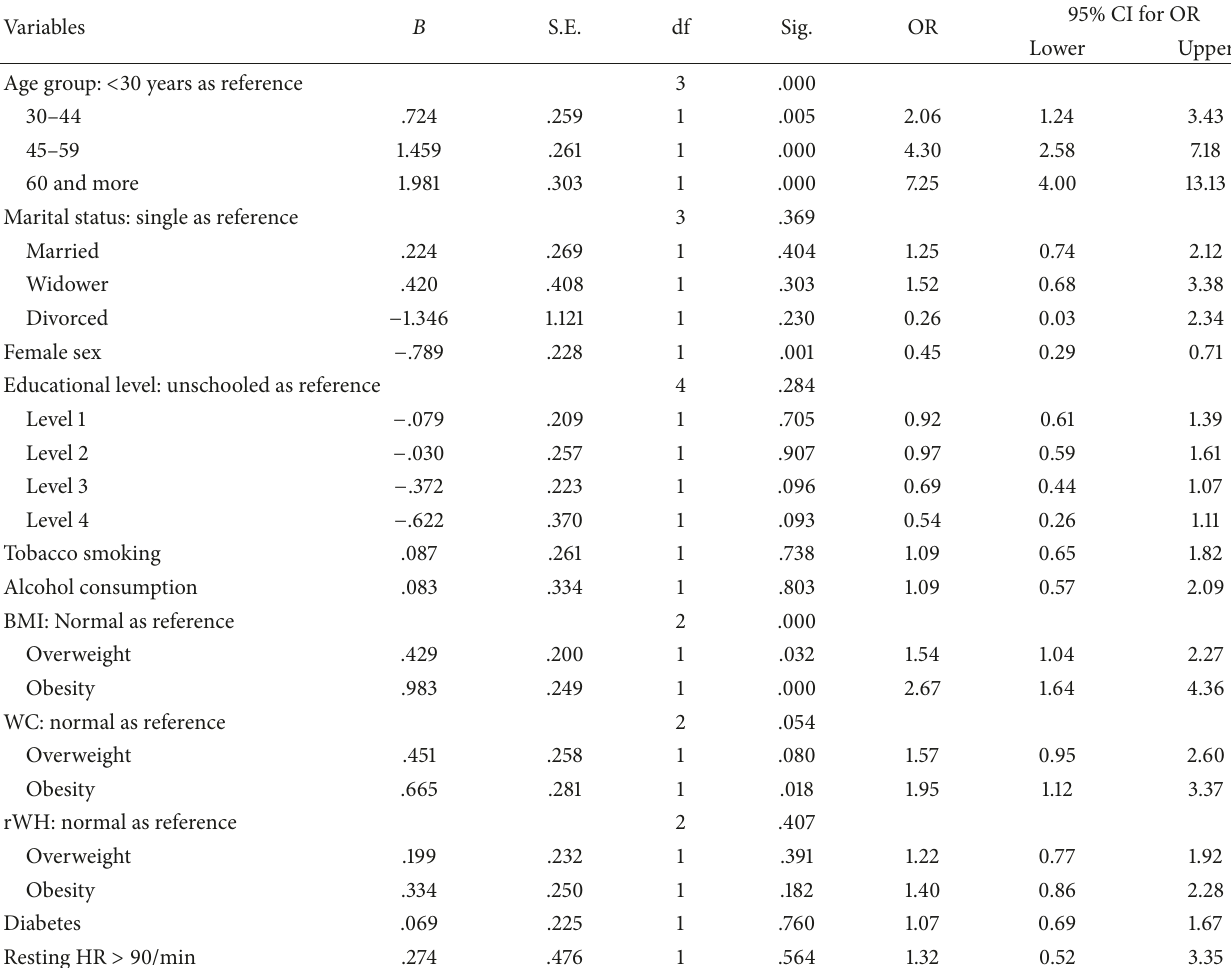
Table 6: Logistic regression predicting hypertension in urban